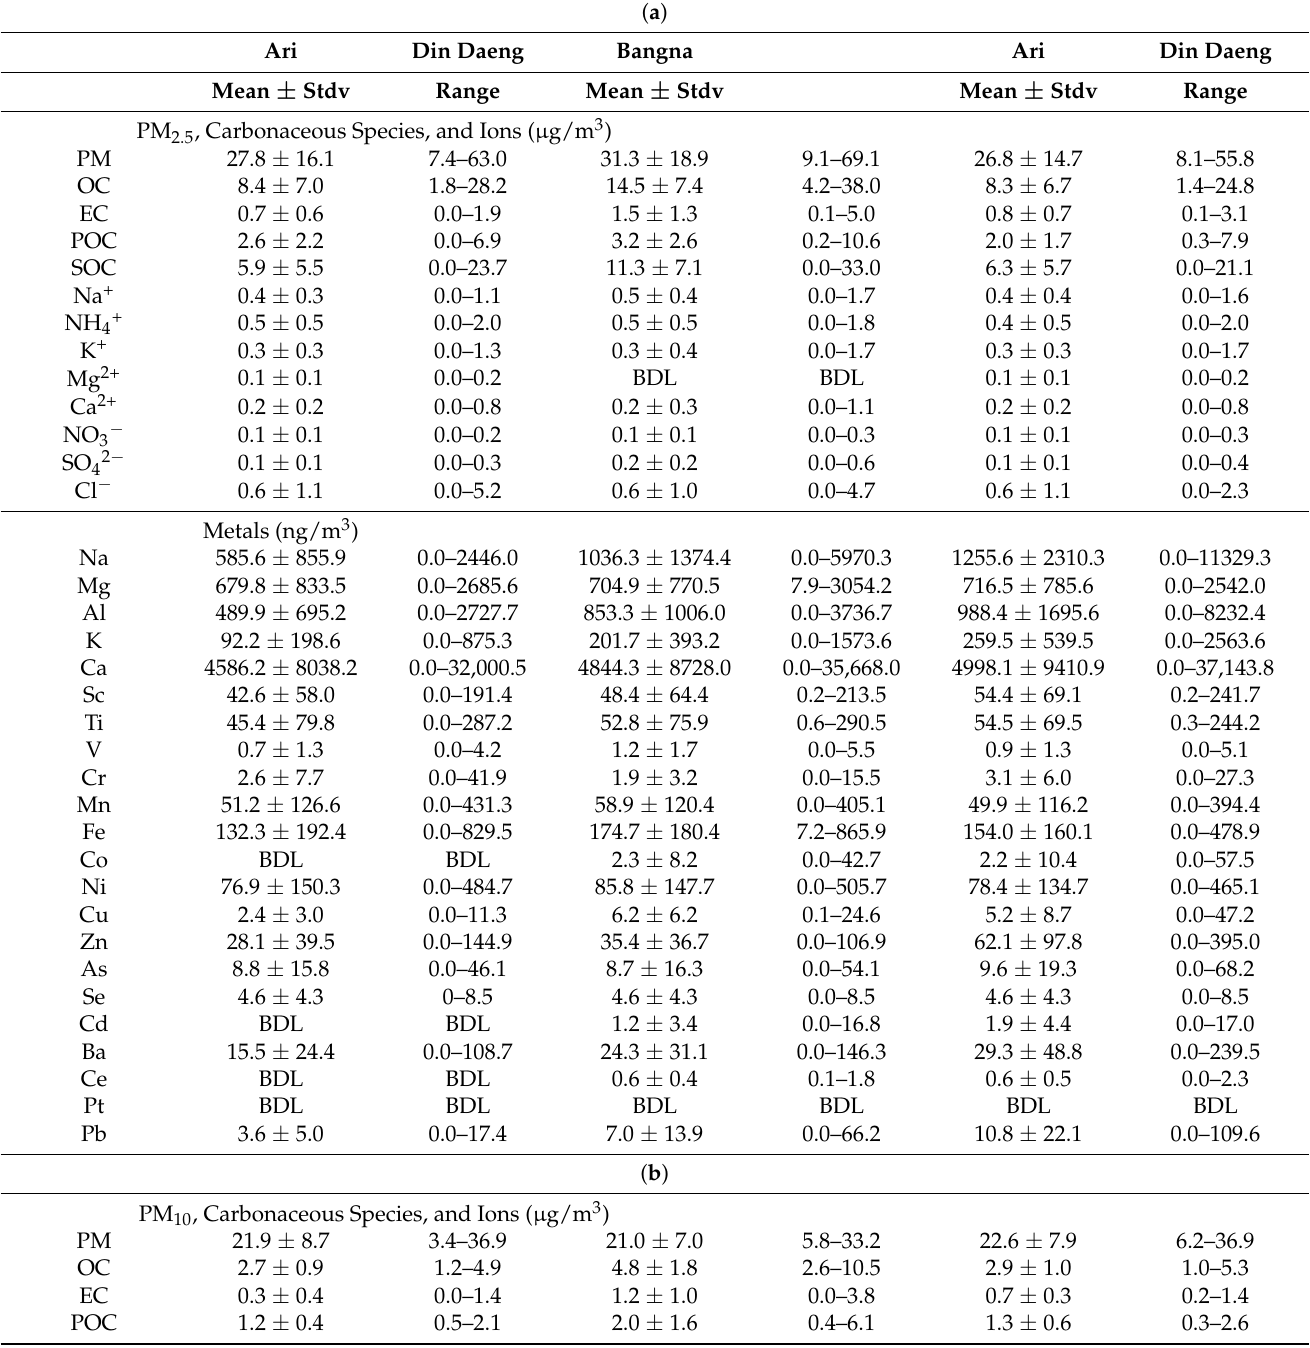
Table 1. ( a ) Mean and range with standard deviations of the chemical species: PM 2.5 at Ari, Din Daeng, and Bangna, Bangkok, Thailand ( b ) Mean and range with standard deviations of the chemical species: PM 10 at Ari, Din Daeng, and Bangna, Bangkok,